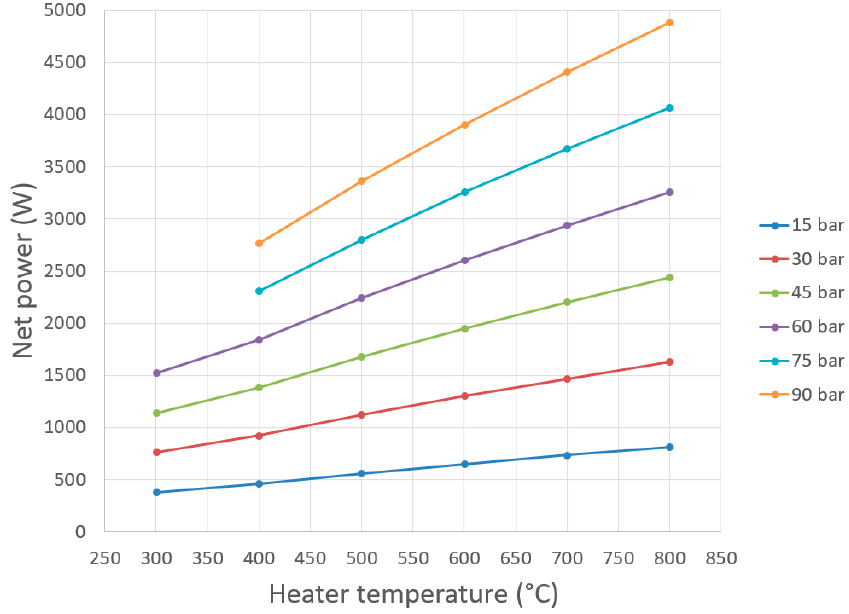
Figure 11. The numerical simulation for different pressures and heater temperatures .